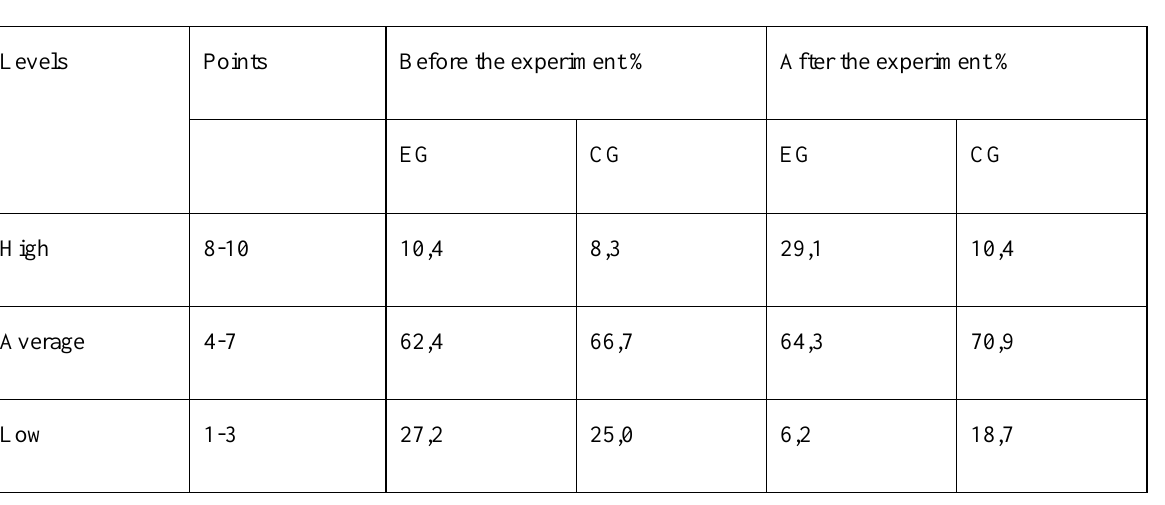
Table 2. Levels of noosphere-aesthetic education of primary school students by means of regional culture